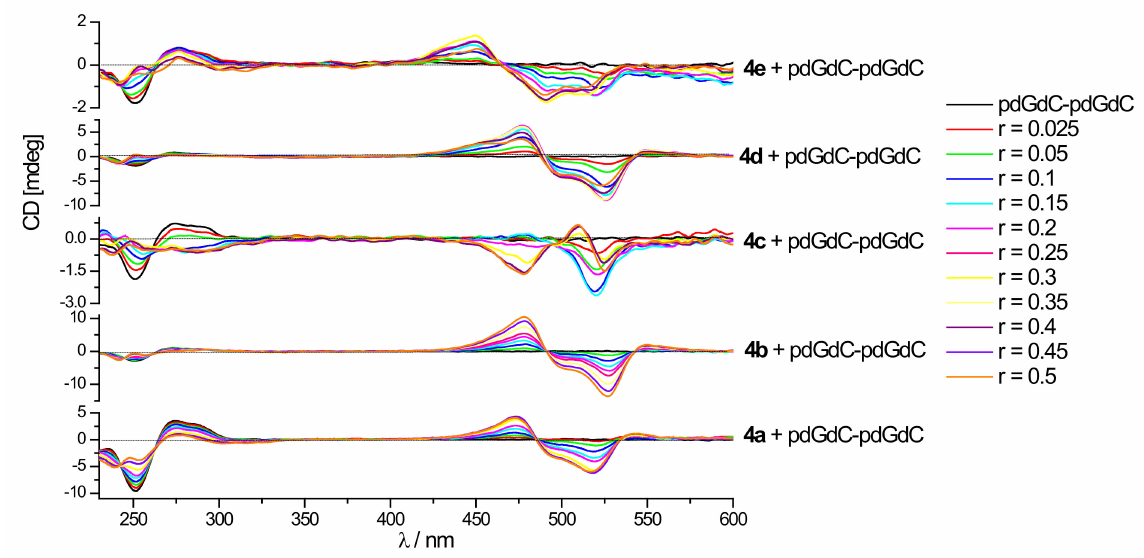
Figure 4. Changes in the CD spectrum of poly dGdC–poly dGdC ( c = 1–2 × 10 -5 mol dm -3 ) upon addition of 4a – 4e compounds at different molar ratios r = [compound] / [polynucleotide], pH = 7.0, sodium cacodylate buffer and I = 0.05 mol dm -3